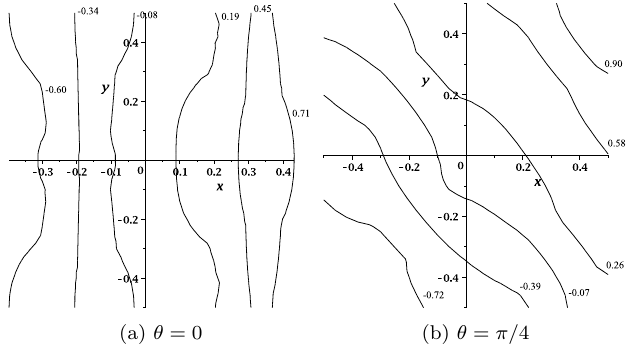
Figure 3. The temperature distribution inside Q (0 , 0) for λ k = 0 . 01, γ k = 100, β k = − 0 . 01, θ = 0; π/ 4.